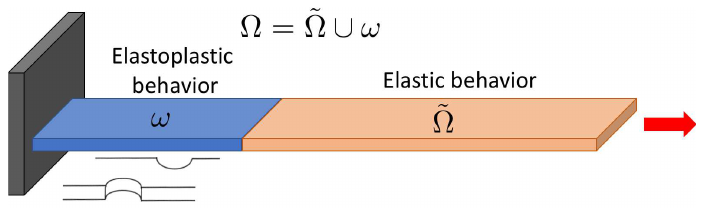
Fig. 5. 3D model Ω composed of a patch ω where inelastic deformation is expected localizing during the loading and the remaining part ˜Ω where only elastic deformations will occur.